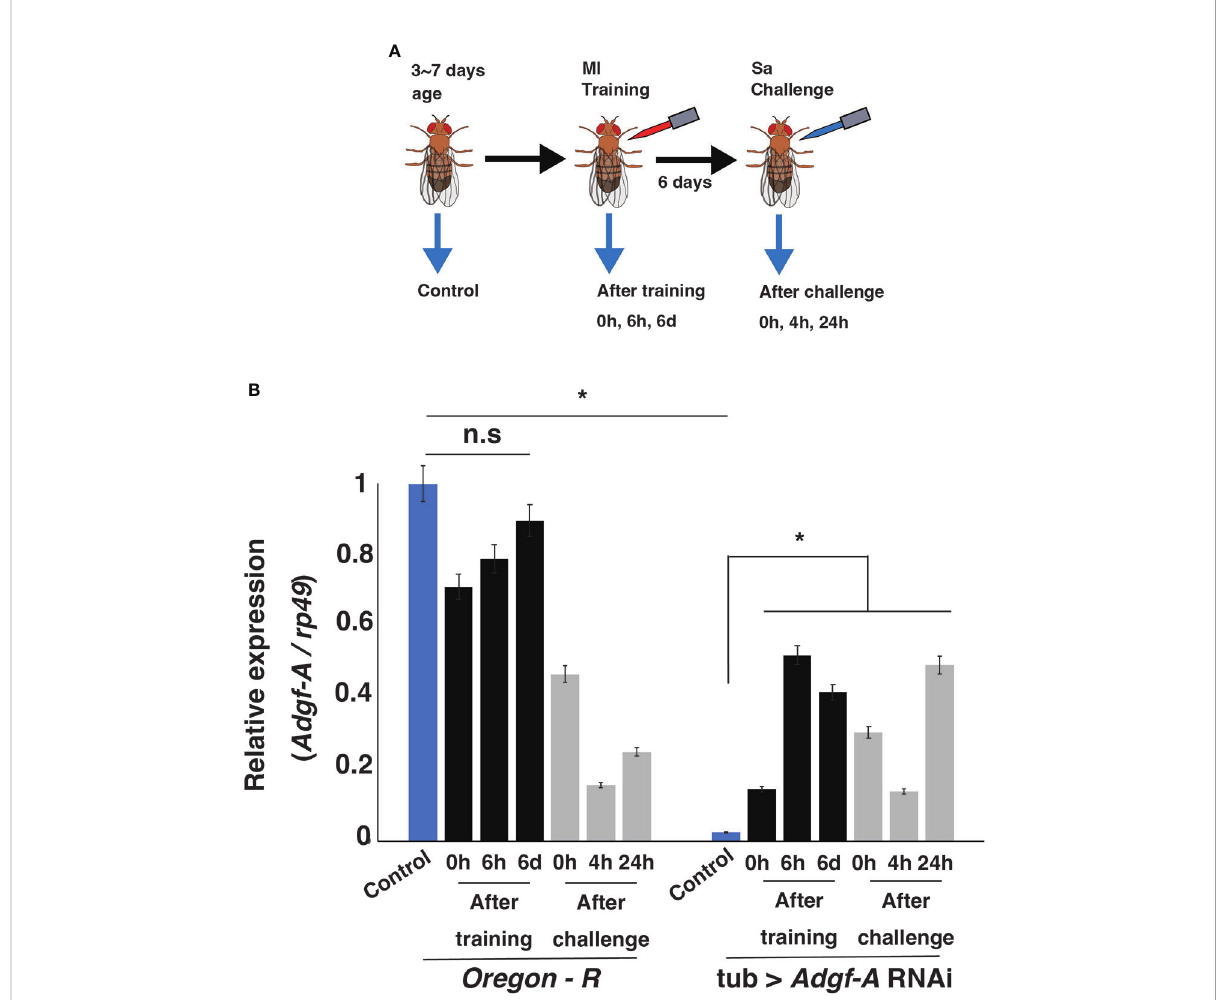
FIGURE 8 Adgf-A expression after training and challenge. (A) Experimental design for RT-qPCR analysis. Adult fl ies from 3 ~ 7 days old (blue bars) and the fl ies at 0 h, 6 h, and 6 d after Ml training (black bars) were sampled. Moreover, 6 days after Ml training, fl ies were sampled at 0 h, 4 h, and 24 h after Sa challenge (gray bars). (B) RT-qPCR analysis of relative expression of Adgf-A against that of rp49 under each condition. *, p < 0.05; n.s., not signi fi cant, determined using one-way